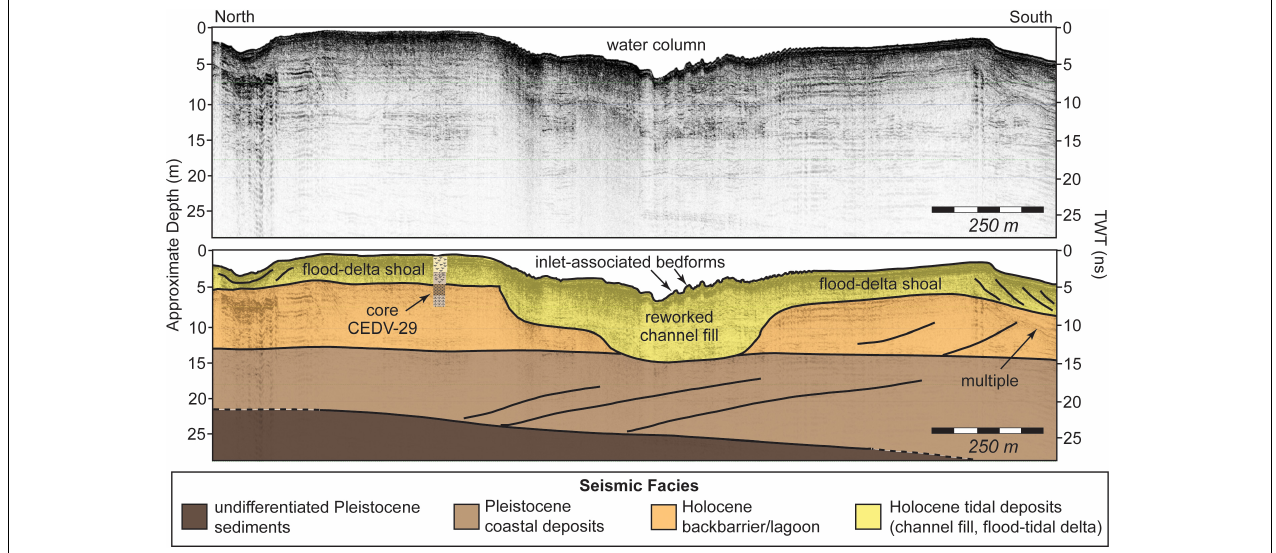
FIGURE 6 | Example of processed (top) and interpreted (bottom) seismic data from Cedar Island backbarrier. Seismic profile line was collected along a north-south transect along the west side of a flood channel extending from Wachapreague Inlet (see location, Figure 4 ). Profile crosses over the location of sediment